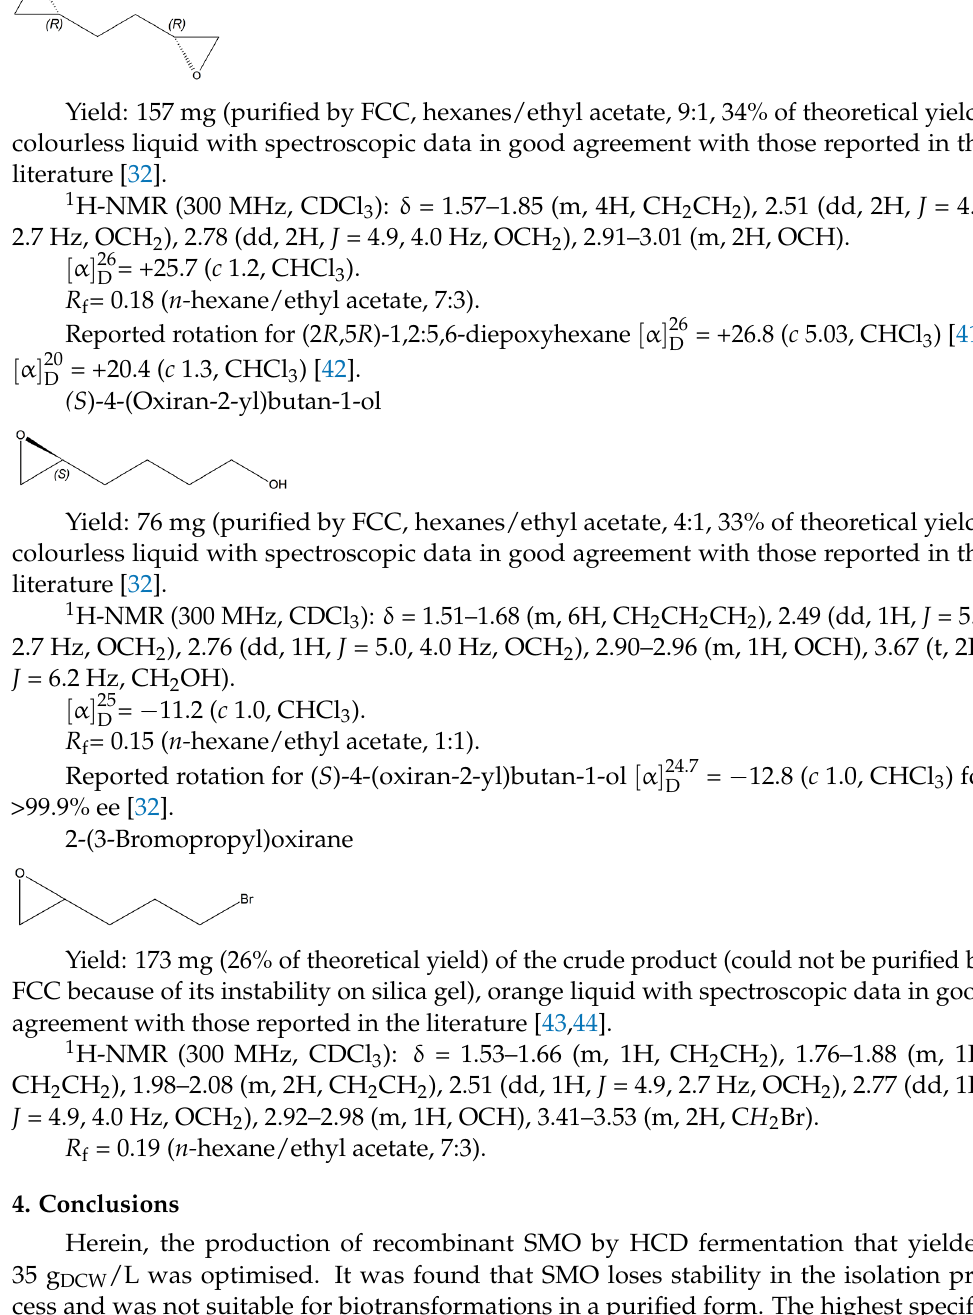
Supplementary Materials: Figure S1: Cell growth after induction of SMO expression (0.25 mM IPTG) in LB and M9 medium and final specific activity of SMO, Figure S2: SDS-PAGE electropho- resis of induction of SMO expression by different concentration of IPTG. OD 600 = 0.7–0.8. Lane 1–